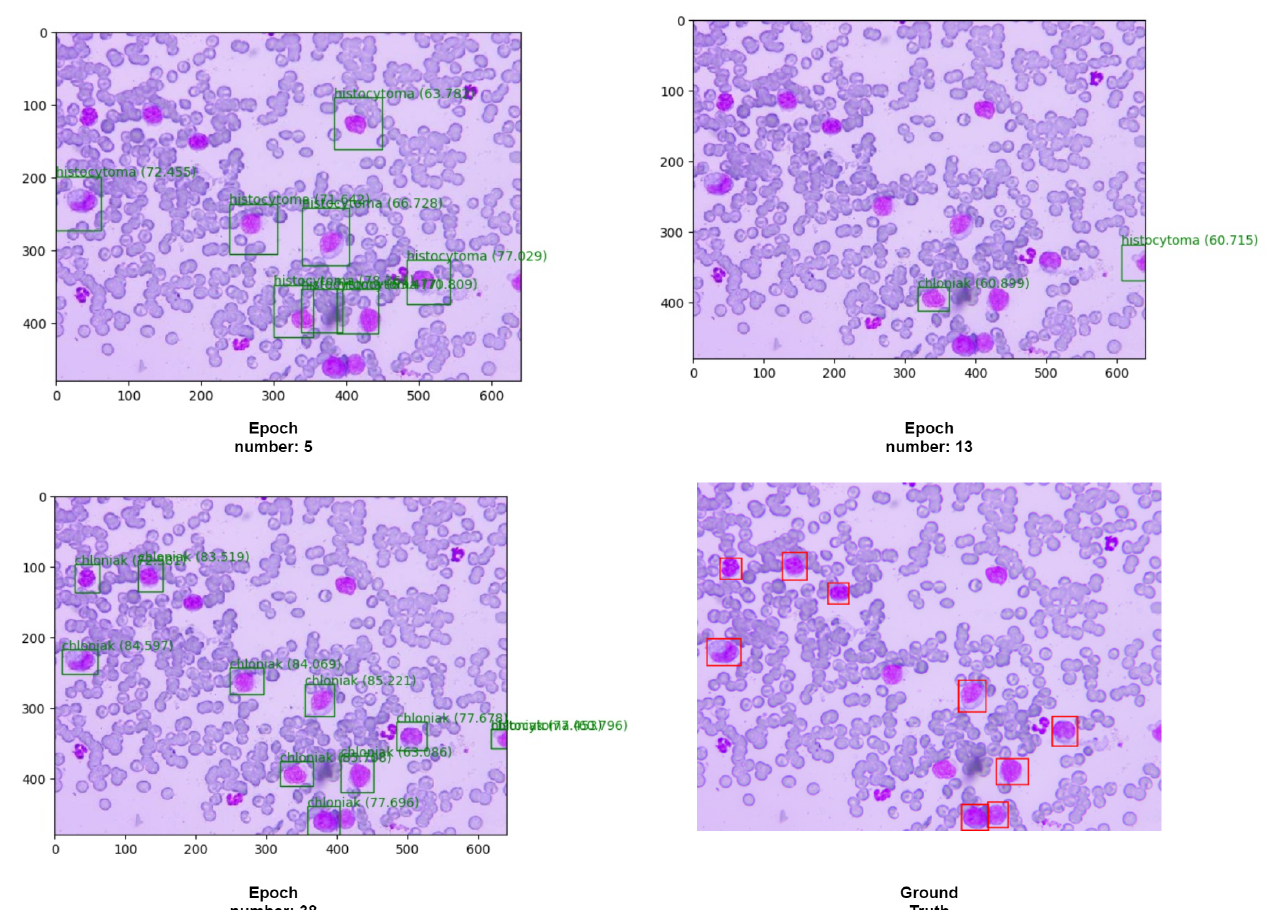
Figure 11. The visualization of the training process at various stages for the same testing